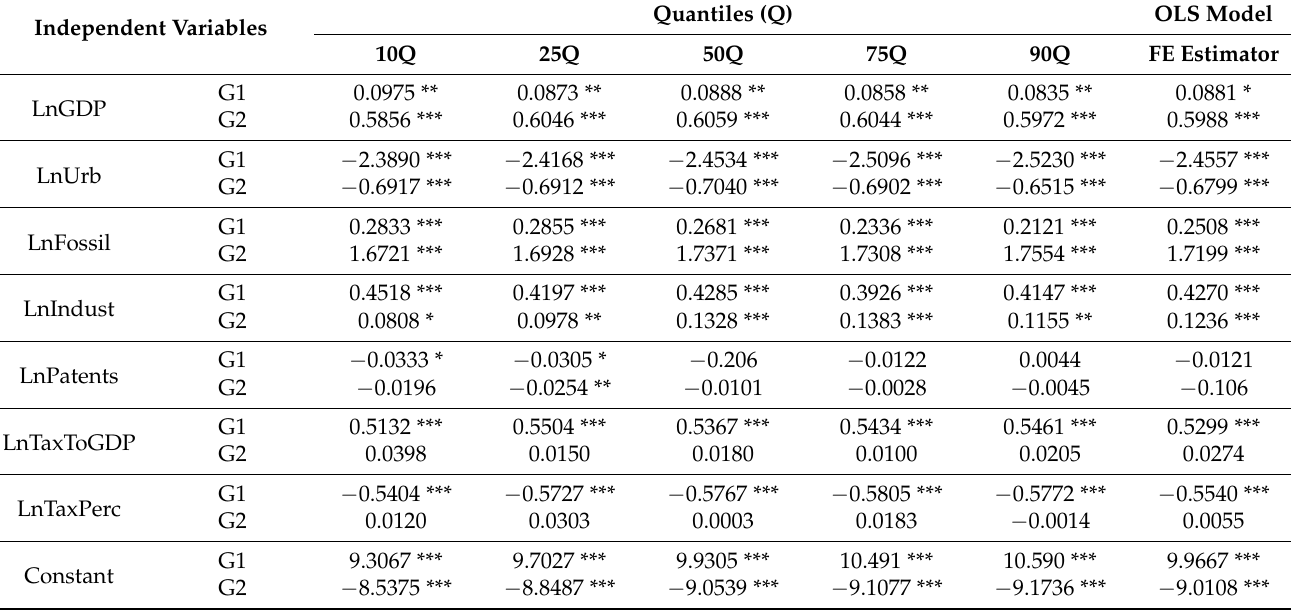
Table 10. Estimations for LnCO 2 for the two groups.